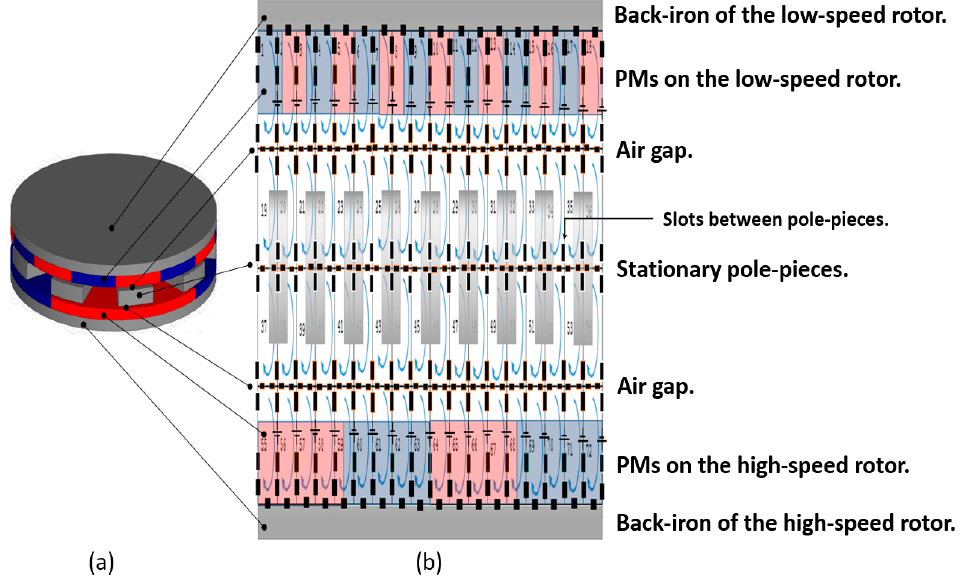
Figure 3. Two-dimensional MEC-RN model of the AFMG: ( a ) structure; ( b ) RN configuration. The mesh-based RN is the basis for the MEC formulation. The base geometry form for each reluctance element is a sector layer, where for 2D modeling, only the axial ( z ) and circumferential ( θ ) components are considered, as shown in Figure 4.